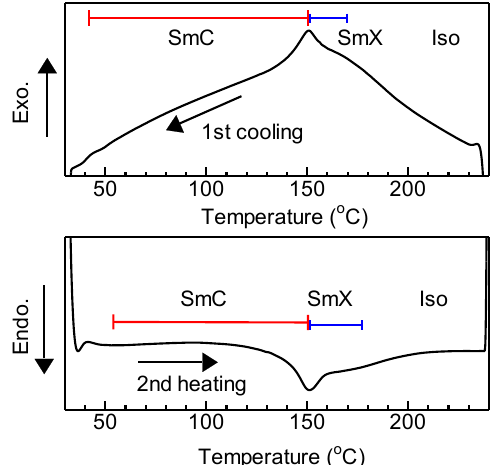
Figure 11. Dynamic scanning calorimetry conducted for poly(Ac–Pyr) in the first cooling and second heating processes.